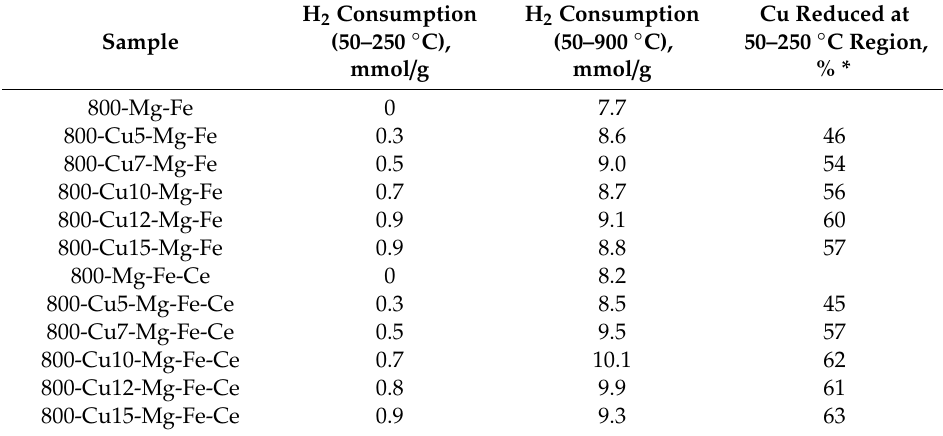
Figure 5. Results of H 2 -TPR measurements ( a ) Cu reduced in first TPR region, ( b ) Cu peak intensity in the second TPR region. Table 7. TPR-H 2 results.